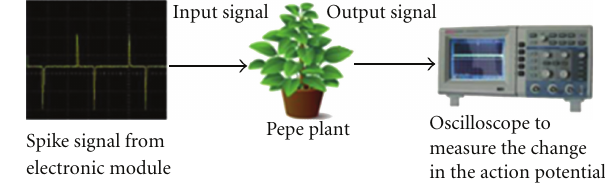
Figure 8: Hierarchy of system for experiment